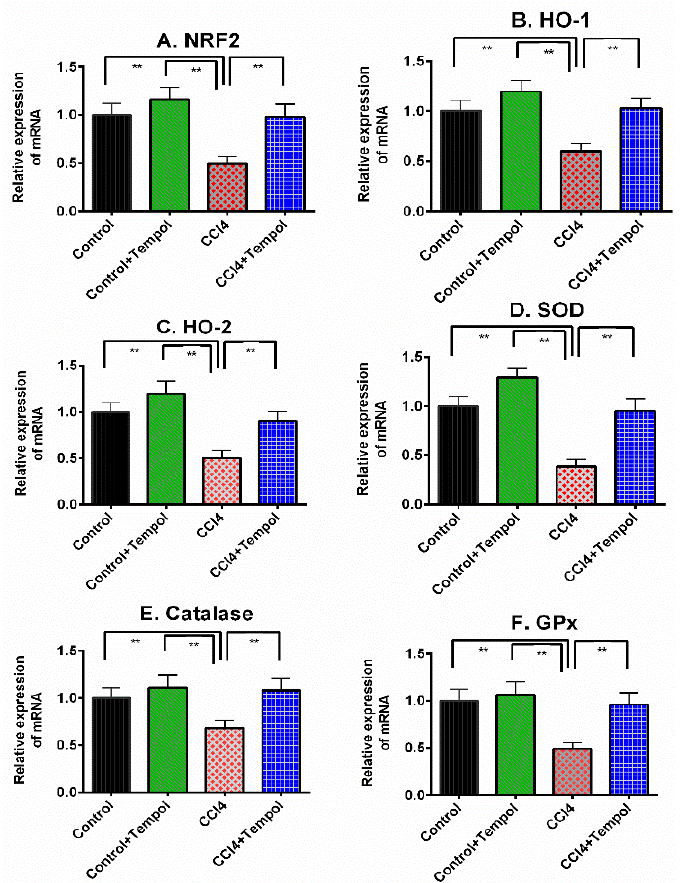
Figure 5. Effect of tempol on antioxidant gene expression in the liver of CCl 4 -administered rats. Every value was represented as mean ± SEM. N = 6. One-way ANOVA followed by Tukey’s test were performed for statistical analysis. For statistical significance, p < 0.05 is considered significant in all cases. Here, ** means p < 0.001.